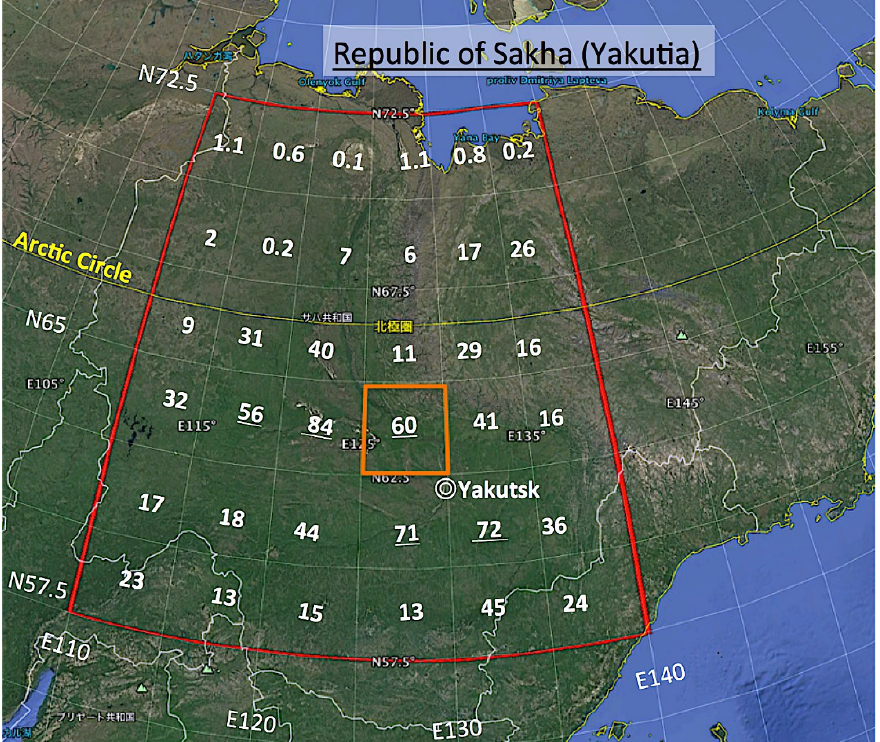
Figure 1. Map of the Republic of Sakha. The region was divided into 36 blocks showing the total number of hotspots (×10 3 ) from 2002 to 2020. The ground total of the hotspots was 877,603. The distance from west to east (from 110° to 140° E) is about 1520 km at 62.5° N. The distance from south to north (from 57.5° to 72.5° N) is about 1670 km. The orange rectangle is the highest fire density area (HFA). Base map made by “Google Earth Pro”.